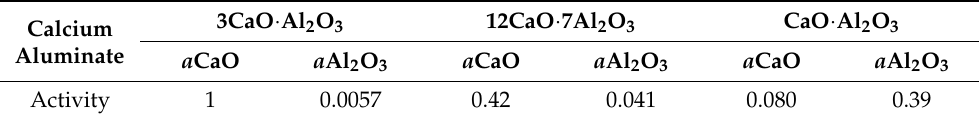
Table 3. Activity values of CaO and Al 2 O 3 inclusions at 1873 K, reprinted from Ref.